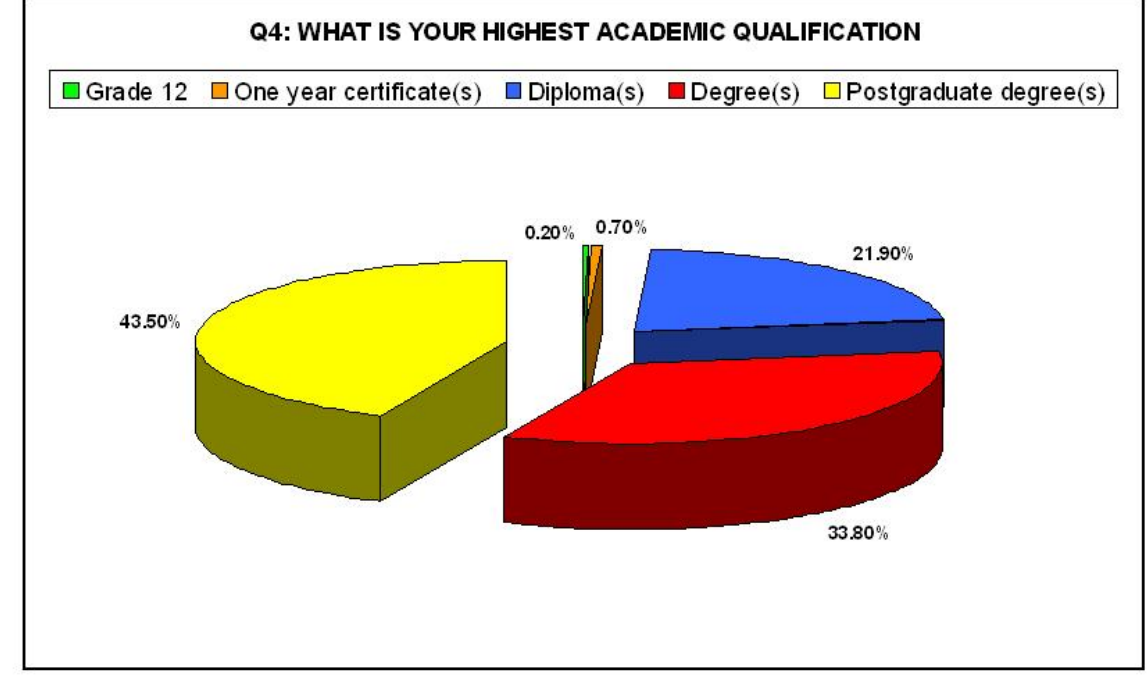
Figure 2 Graphic representation of the responses to Question 4 of the survey